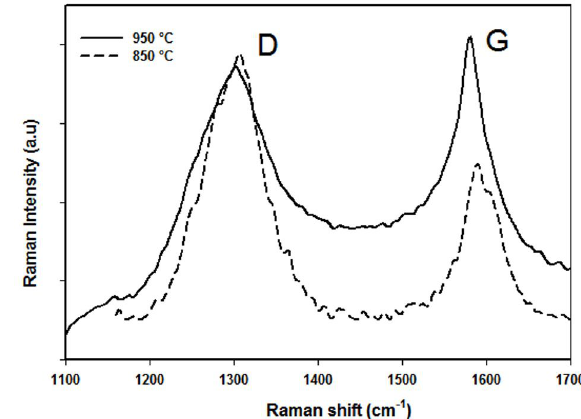
Fig. 9. Typical Raman spectra of Zn Zn CNT 2 850